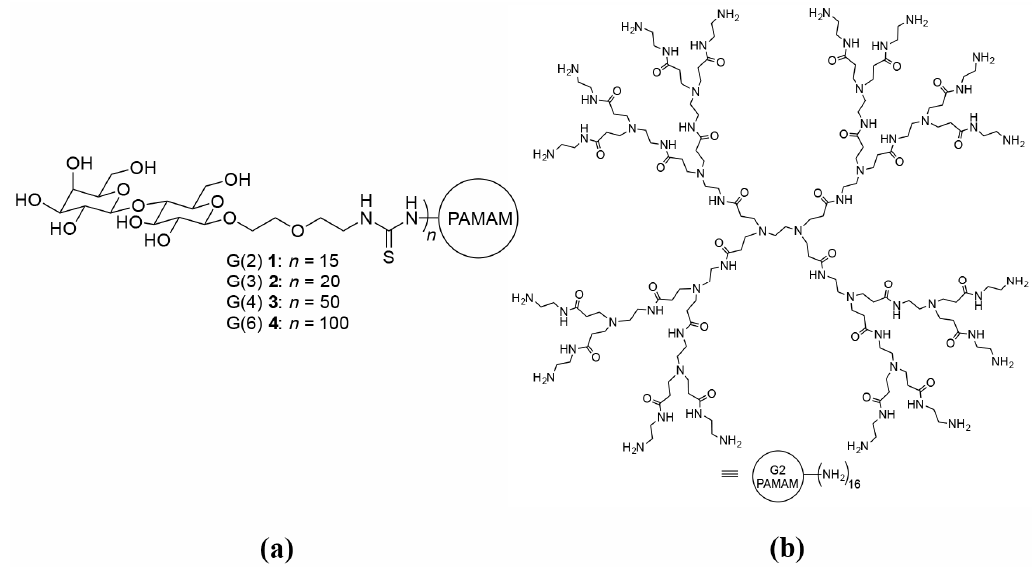
Figure 10. ( a ) Lactose functionalized poly(amidoamine) (PAMAM) dendrimers used; and ( b ) PAMAM